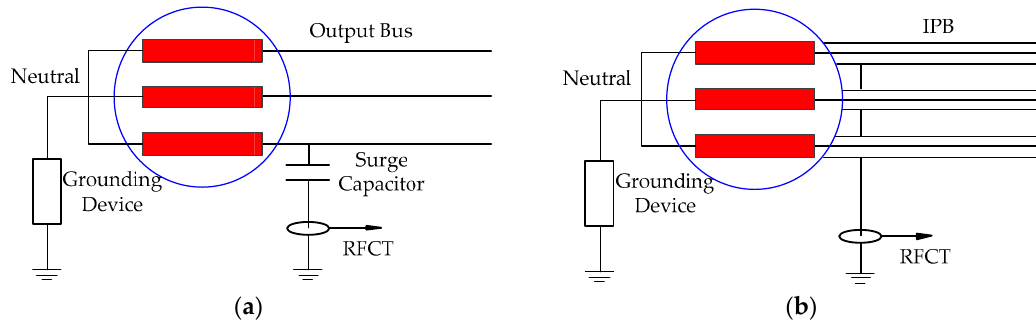
( a ) ( b ) Figure 7. HVCT ( a ) Surge capacitor; ( b ) Equivalent capacitor [48,56]. Table 3. Characteristics of a part of PD online measurement systems for large generators. Detection